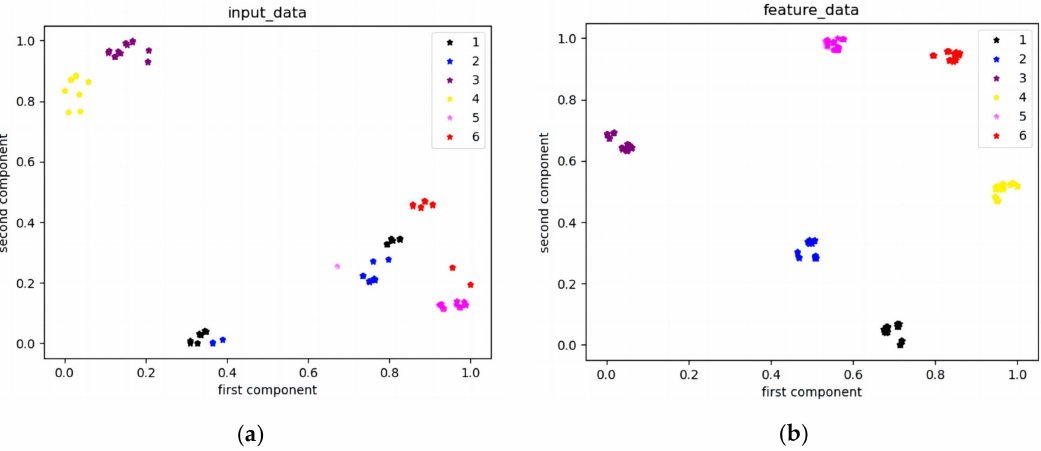
Figure 13. The mapping characteristics of input data and output results.